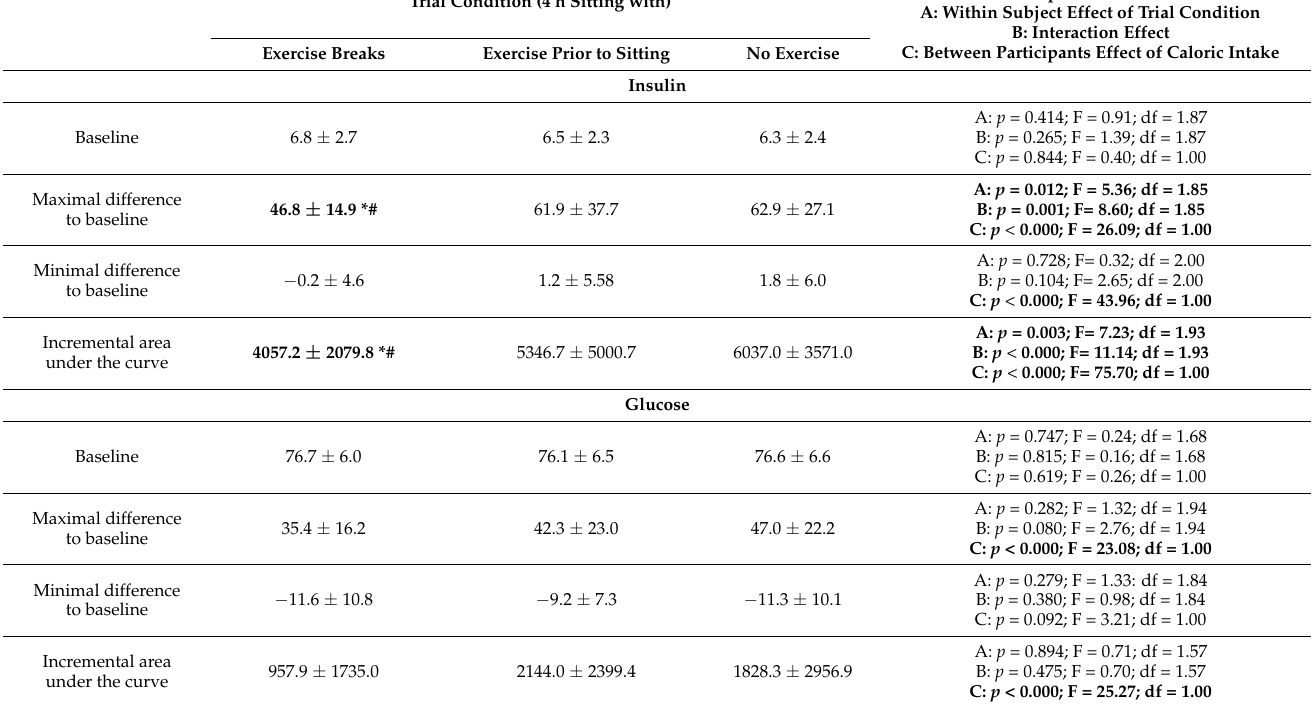
Table 2. Left columns: descriptive data for blood insulin in microunits per milliliter ( µ U/mL) and glucose in milligrams per deciliter (mg/dL), indicated as baseline, maximal and minimal difference to baseline, and descriptive data for mood and well-being. Incremental area under the curve (iAUC) for insulin, indicated as microunits per milliliter per time in minutes ( µ U/mL · min) and, for glucose, indicated as milligrams per deciliter per time in minutes (mg/dL · min). For mood and well-being, all positive (arousal, elevated mood, thoughtfulness, peace of mind) and negative outcomes (anger, agitation, depression, lack of energy) are indicated. Mean value and standard deviation are given for all outcomes in all trial conditions (exercise breaks, prior exercise, and no exercise control). Right column: results of repeated measures ANCOVA for within-subject (intervention), between-subject (caloric intake), and interaction effects. Level of significance is p = 0.05. Significant results er indicated by bold font * = significant difference to no exercise control, # = significant difference to trial with prior